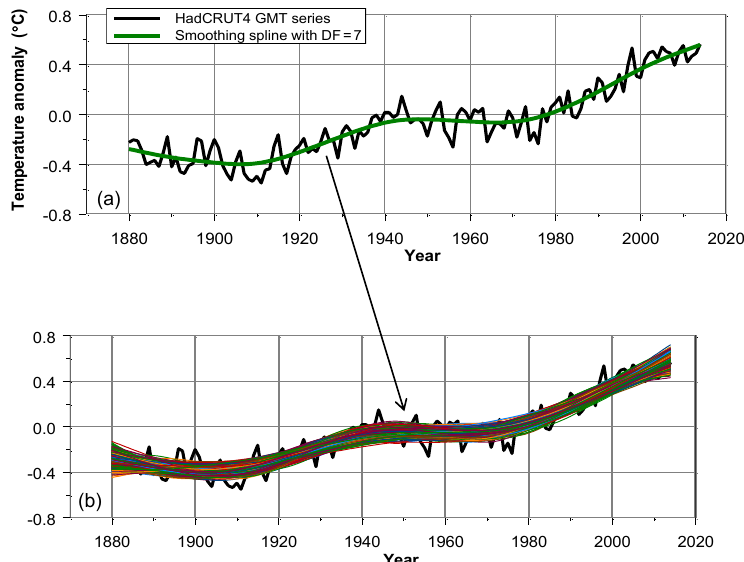
Figure 2. Construction of 1000 surrogate trend series by MC simulation, based on cubic splines. The AR(1) parameter estimated on the residuals of the spline model in (a) accounts for 0.28. A surrogate GMST series ˆ y i,t is formed by simulating a new residual series r i,t based on the AR(1) process with ϕ = 0 . 28, and adding it to the estimated spline (green line in a ). Then, a spline trend µ i,t is estimated for each surrogate ˆ y i,t . As an illustration we have plotted 1000 of such trends µ 1 ,t ,...,µ 1000 ,t in (b) . Now, confidence limits can be estimated for any µ t based on the values µ 1 ,t ,...,µ 1000 ,t . These confidence limits can be based on SDs or percentiles. Similarly, confidence limits can be calculated for the increment [ µ 2016 − µ 1880 ], based on the values [ µ 1 , 2016 − µ 1 , 1880 ], ..., [ µ 1000 , 2016 − µ 1000 , 1880 ] (Mudelsee, 2014 – Sects. 3.3.3 and